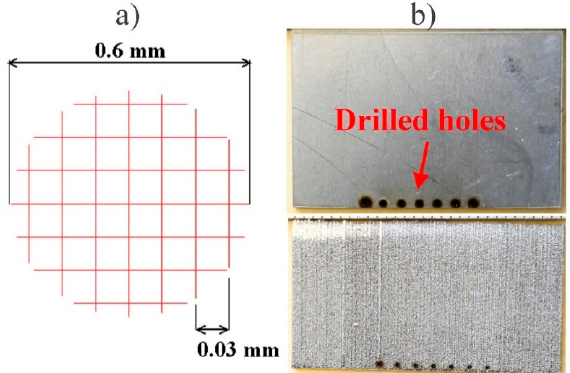
Figure 3. ( a ) Hatch pattern illustration for the engraving, not in scale. Red lines denote laser beam movement. ( b ) Photographs of the drilled sheets, drilled holes were 2 mm apart. Cold rolled sheet on top, PBF sheet on bottom.